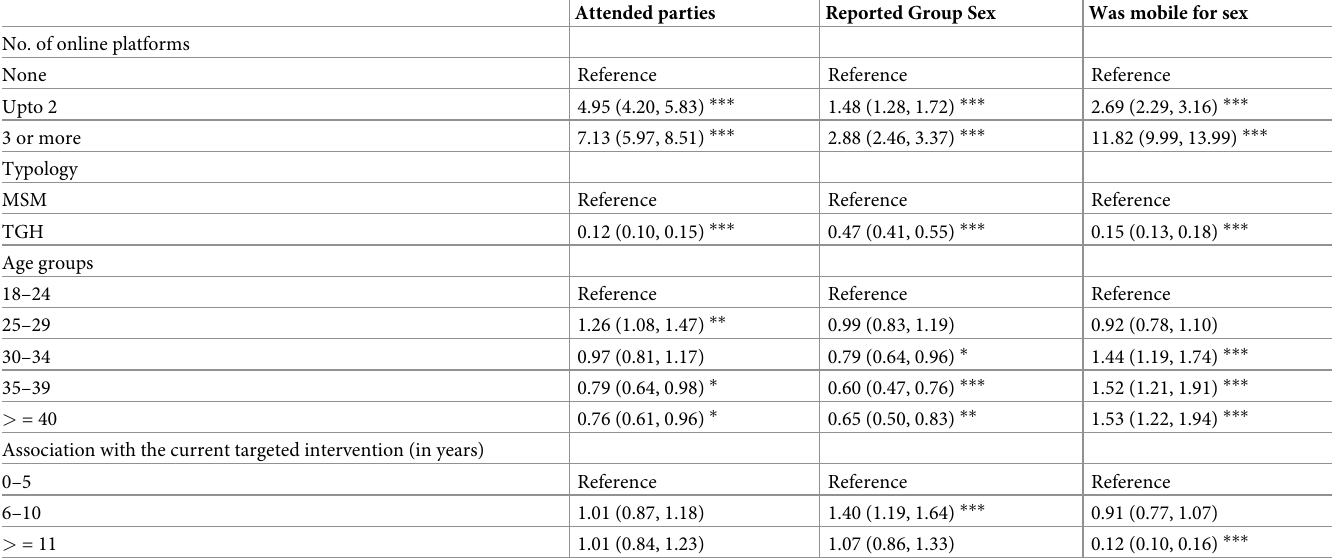
Table 3. Logistic regression models showing the factors associated with risk behaviours in 8582 MSM and 4163 TGH, Mumbai, India.